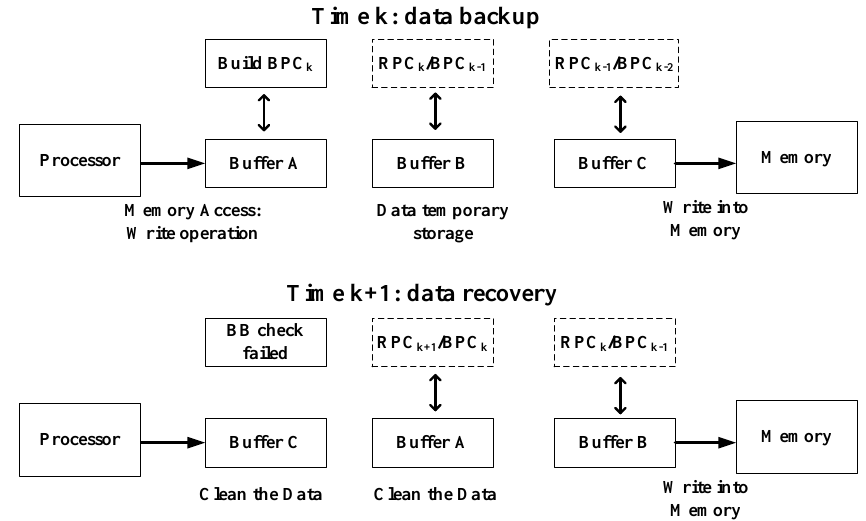
Figure 9. The principle of data backup and